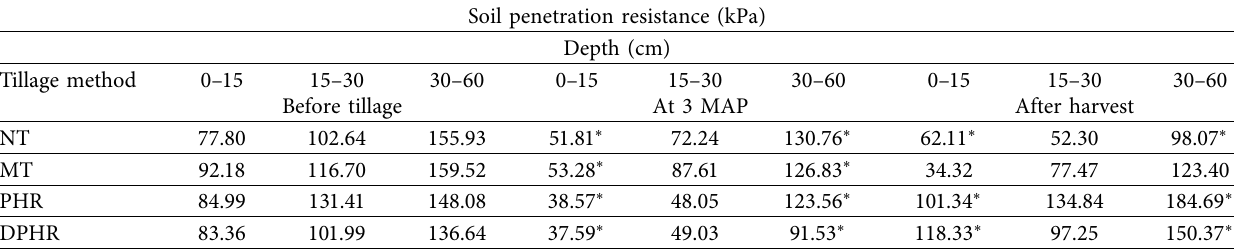
Table 6: Tillage method’s effect on penetration resistance.